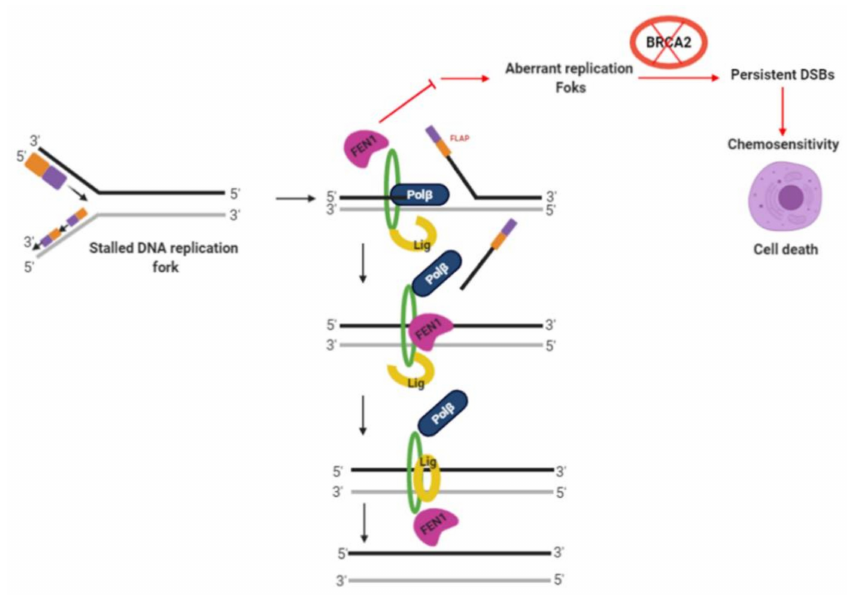
Figure 7. FEN1 and synthetic lethality. BRCA2 deficient cells accumulate replication fork interme- diates. FEN1 has an important role during replication. FEN1 blockade in BRCA2 deficient cells will increase replication stress, leading to accumulation of DSBs and cell death. FEN1 also inter- acts with Pol β during BER. In Pol β deficient ovarian cancer cells, FEN1 blockade can increase SSB accumulation which will lead to DSB accumulation and cell death. DSB = double-strand